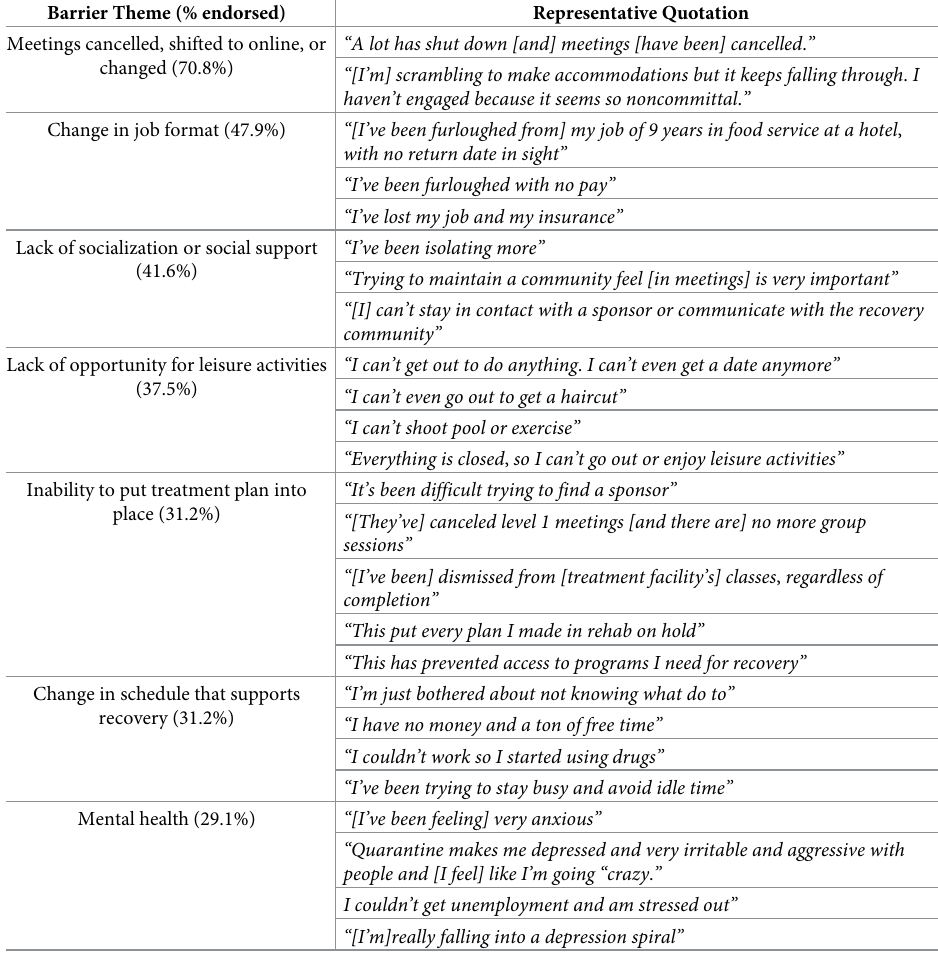
Table 3. Themes of barriers to recovery with representative quotations. Barrier Theme (% endorsed) Representative Quotation Meetings cancelled, shifted to online, or changed